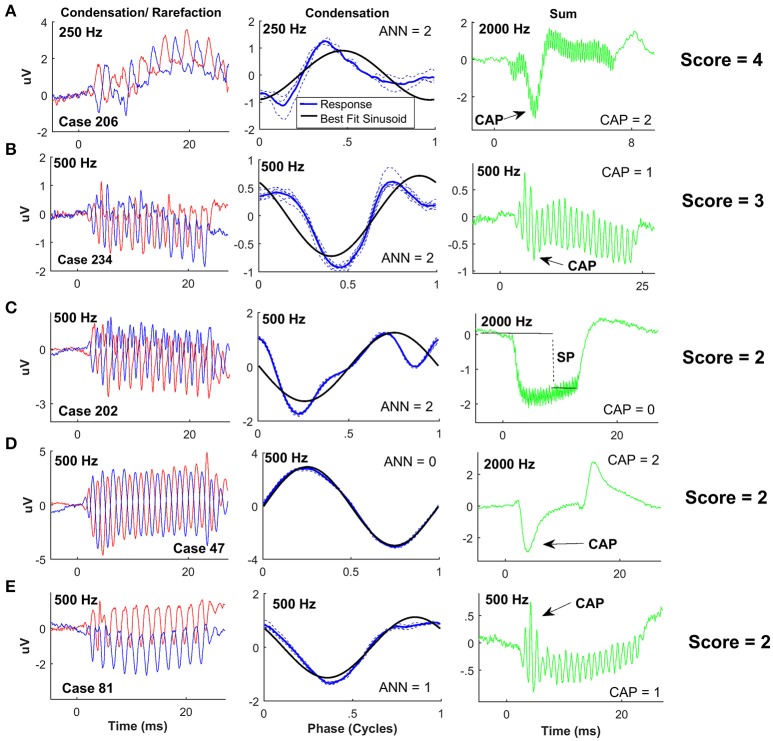
ECochG examples of ANSD subjects with considerable evidence of neural activity. For each case the response to condensation and rarefaction phase of a low frequency stimulus is shown on the left. The middle panels show the individual (dotted lines) and average cycles (thick line) to condensation phase stimuli taken from a window (8–20 ms) intended to isolate the ongoing, or steady state portion of the response. The solid black line is the best fit sinusoid. The right panels show the sum of responses to the two phases, for the frequencies as shown, which isolates the CAP and SP. (A) Phenotype demonstrating a score of 4, with a strong ANN shown by the distortions on the average cycles, and a strong CAP to 2,000 Hz. (B) This case had a nerve score of 3 with a strong ANN and small but clear CAP. (C) A case with a nerve score of 2, and a phenotype demonstrating a strong, ANN but no CAP, and a large negative SP. (D) Another case with a nerve score of two with no apparent ANN but a strong CAP. Here the SP was small. (E) Another nerve score of two with a phenotype showing a small CAP and ANN.